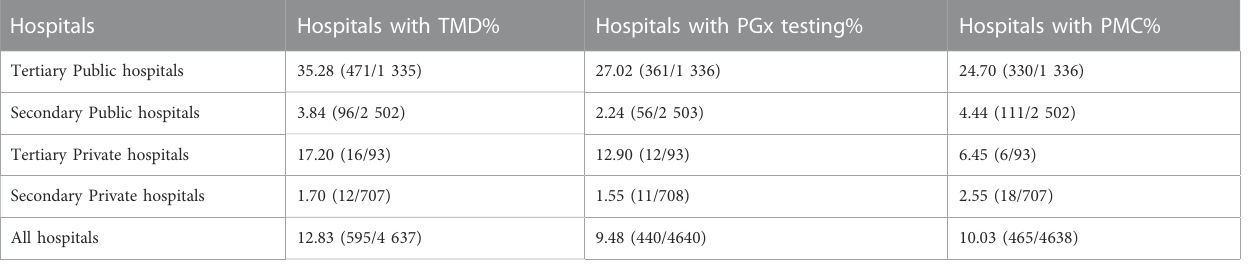
TABLE 2 The percentage of hospitals with TMD, PGx testing and PMC. Hospitals Hospitals with TMD% Hospitals with PGx testing%